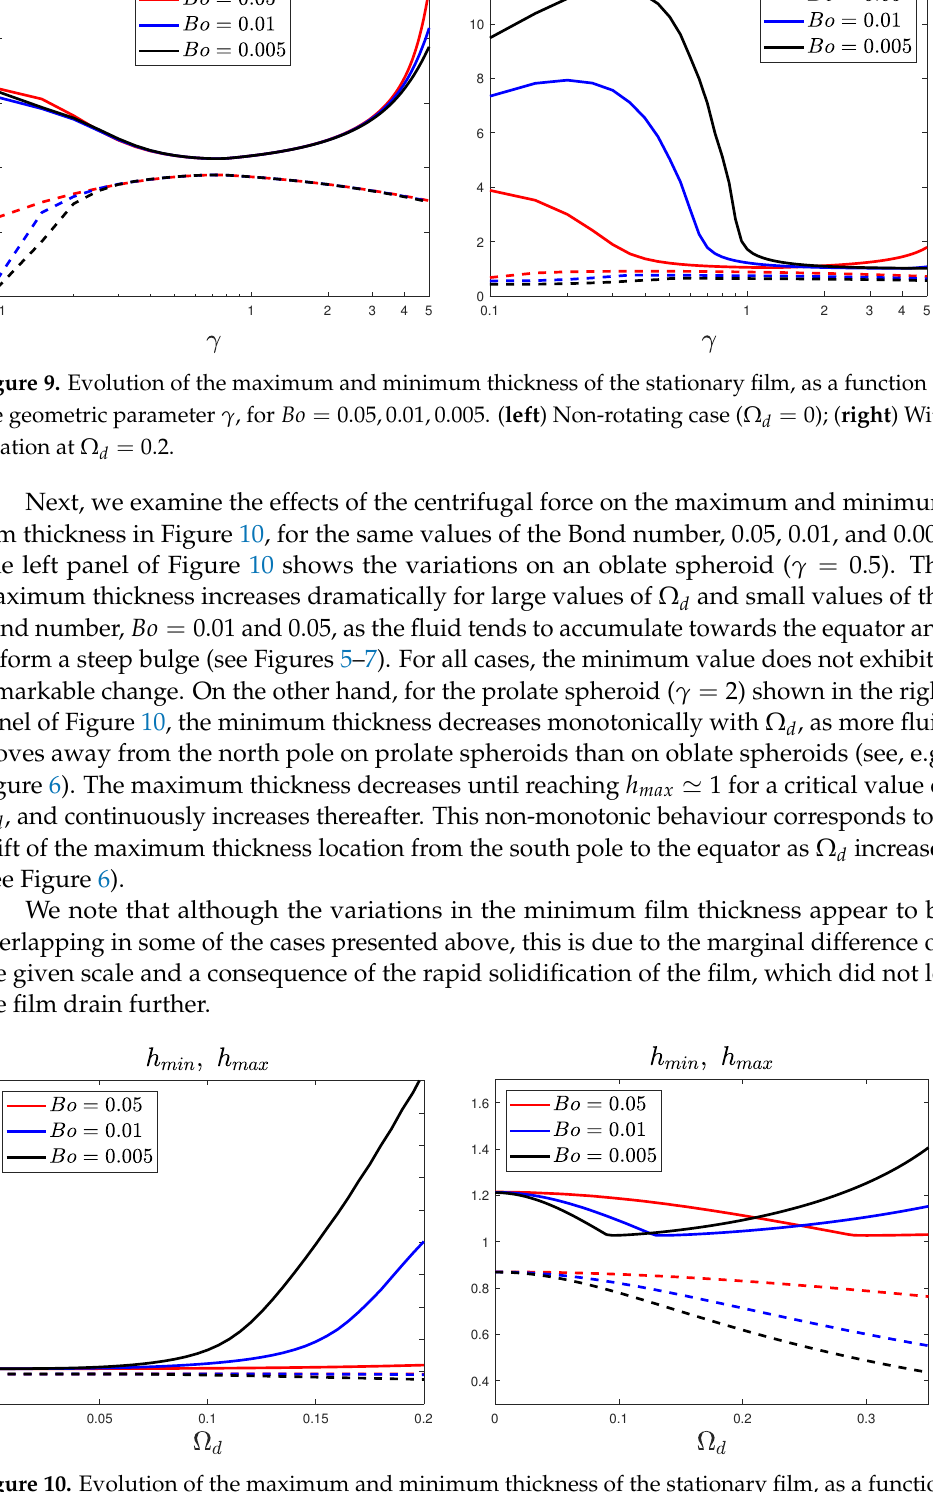
Figure 10. Evolution of the maximum and minimum thickness of the stationary film, as a function of the angular velocity Ω d , for Bo = 0.05,0.01, 0.005. ( left ) Oblate spheroid, γ = 0.5; ( right ) Prolate spheroid, γ =